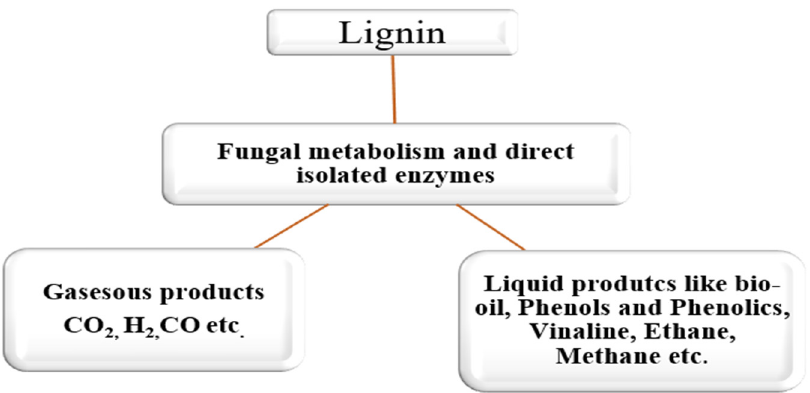
Figure 18. Lignin depolymerization by fungal metabolisms method and their isolated enzymes.